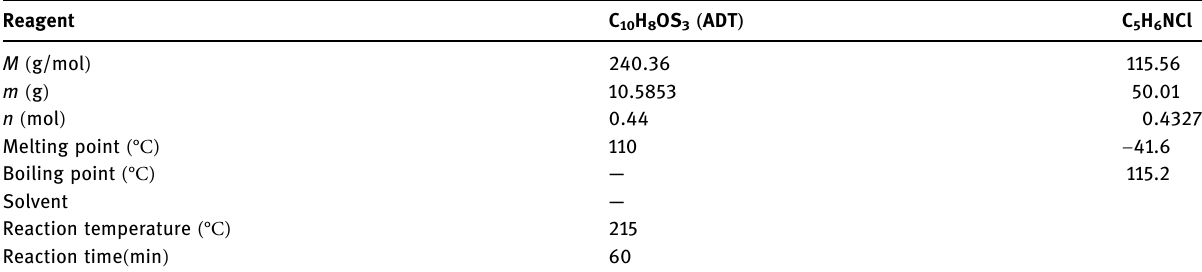
Table A1: Synthesis of ADT -